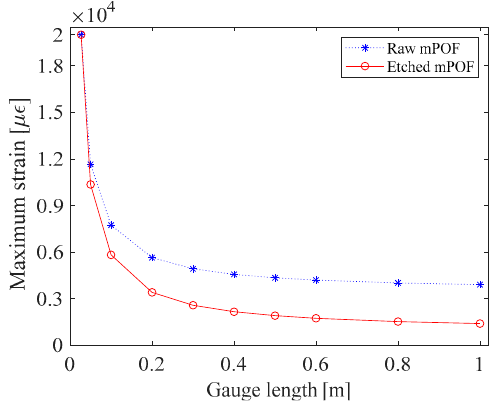
Figure 5. Maximum strain on the fiber sensing heads, considering an elastic regime.